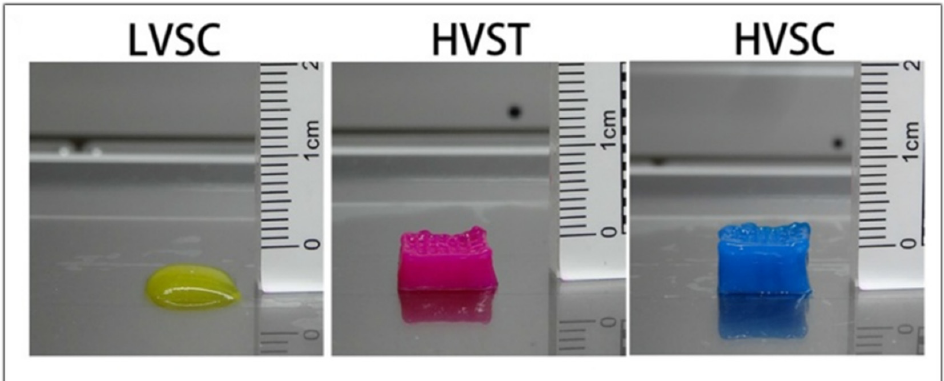
Figure 10. Images of the scaffold obtained with low viscosity cylindrical tip (LVSC), high viscosity tapered tip (HVST), and high viscosity cylindrical tip (HVSC). Adapted from [79]. When developing a dECM bioink for tendon regeneration, Toprakhisar et al. ob- tained a hydrogel from decellularized bovine Achilles tendon with no need for an extra gelation kinetics. This was carried out by using an aspiration–extrusion bioprinting pro- gelation before extrusion by heating the pre-gel solution at 37 °C [73].